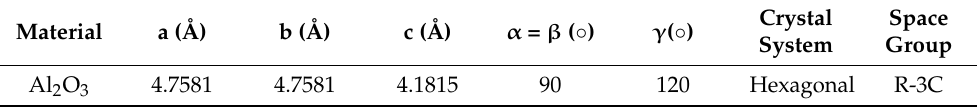
Table 3. Crystal structure and lattice parameters of Al 2 O 3